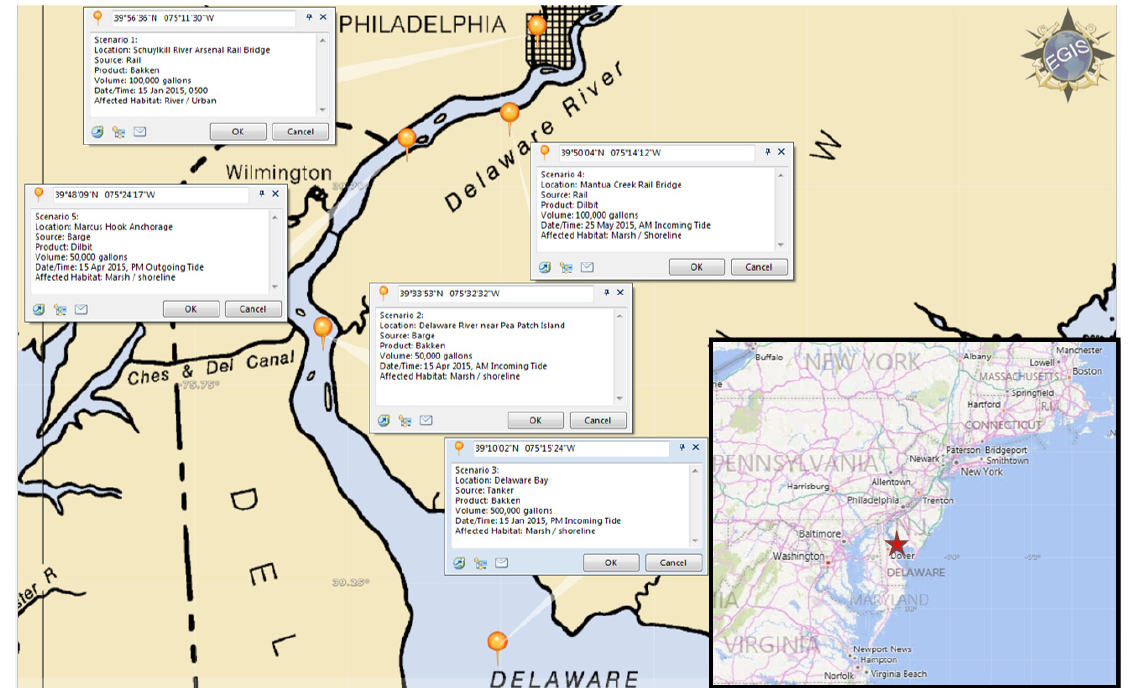
Figure 3. Locations of the five scenarios. Inset shows the location of the study area—the Delaware Bay estuary in the mid ‐ Atlantic region of the US.